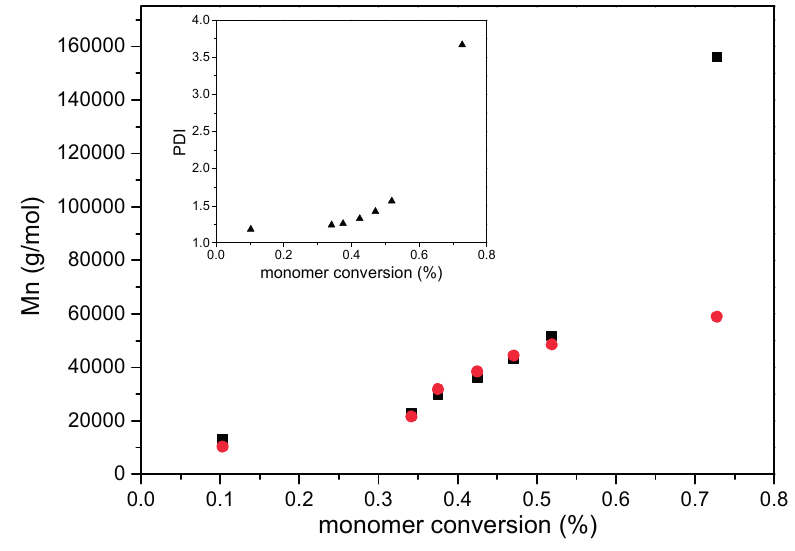
Figure 3. Molecular weights ( M n ) and polydispersity (PDI, inset,  ) of de-grafted polymer (  ) and free polymer (  ) as a function of monomer